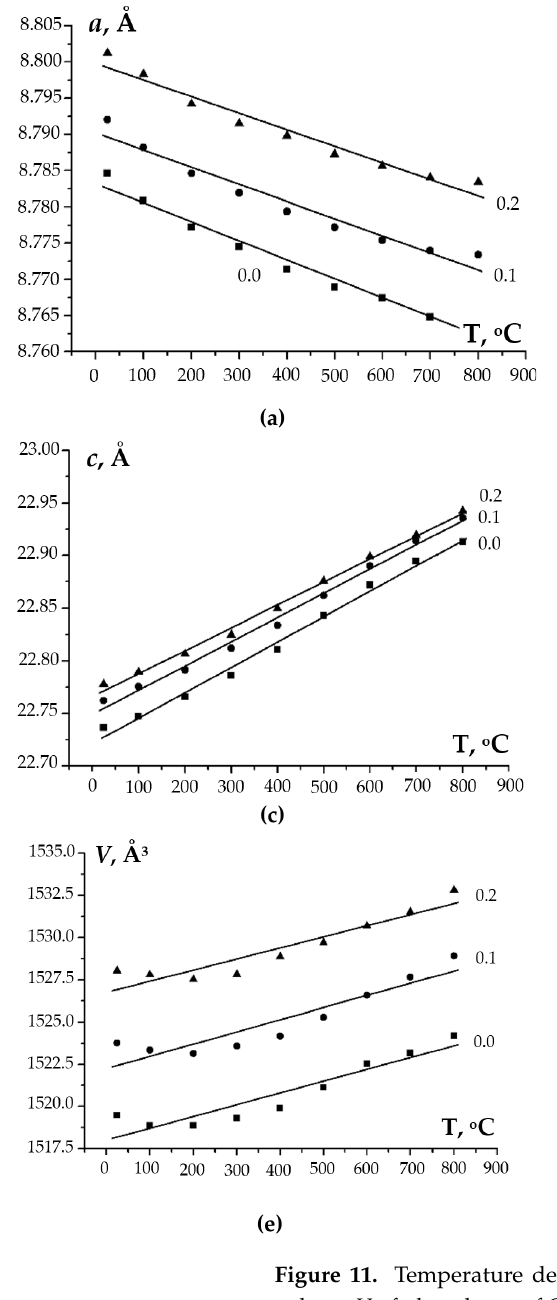
Figure 10. Temperature dependencies of the unit cell parameters a and c , and of the unit cell volume